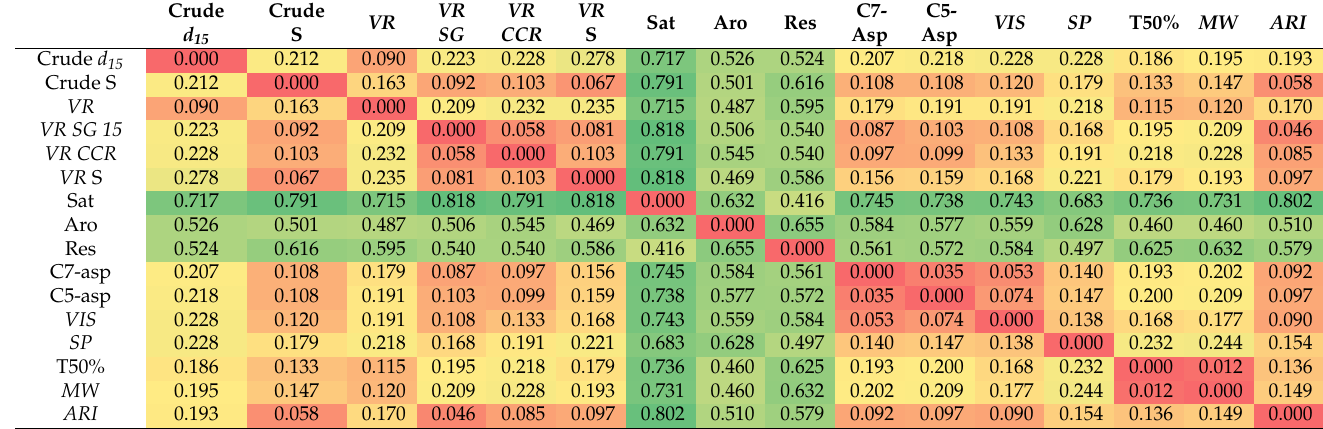
Table 6. The υ -values for the ICrA evaluation of relations between properties of the studied SRVR s.